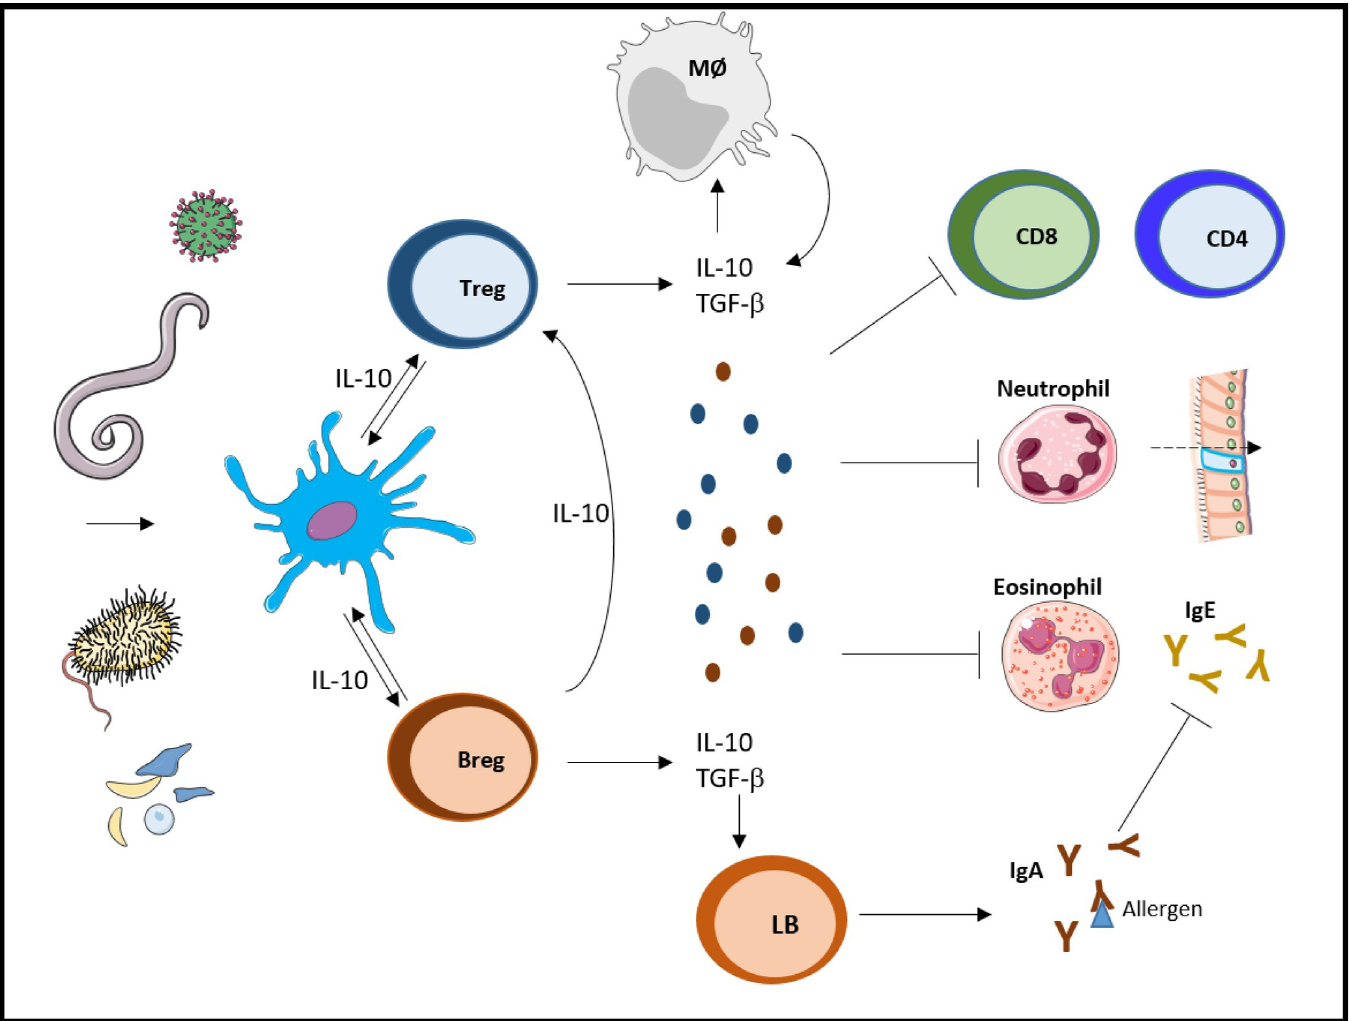
Fig 3. Immune response modulation by pathogen-activated regulatory T and B cells. Virus, bacteria, parasite, or pathogen-derived molecules could induce the development of a regulatory immune response by activating lymphocytes or DC, which stimulate Treg or Breg via the production of IL-10. Together, regulatory cells produce immunomodulatory cytokines like IL-10 and TGF- β , which inhibit CD4 + and CD8 + T cell differentiation and functions, chemokine-mediated neutrophil infiltration, eosinophil inflammatory response, and stimulate B cells to produce modulatory IgA, which neutralize allergen and control IgE. Consequently, the clinical outcome of a concomitant disease could be impacted positively or negatively by regulatory T and B cells, depending on the nature of the pathology. Breg, regulatory B cell; DC, dendritic cell; IgA, immunoglobulin A, IgE, immunoglobulin E; IL-10, interleukin 10; TGF- β , transforming growth factor beta; Treg, regulatory T cell.